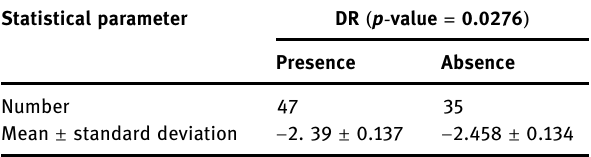
Table 3: Standard deviation and mean for DR in E - ophtha - EX